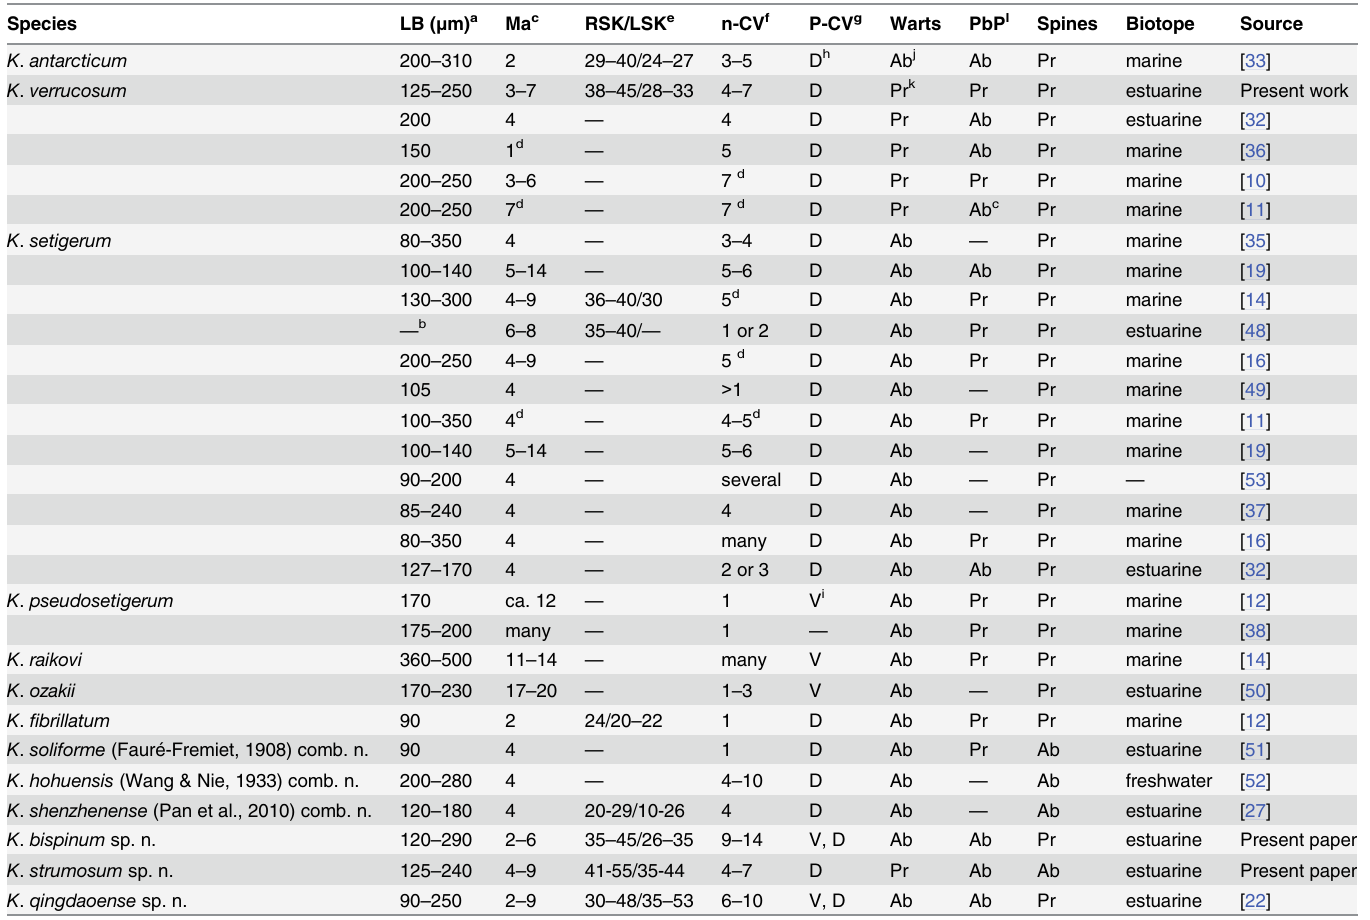
Table 1. Morphological comparison of all known species of Kentrophyllum